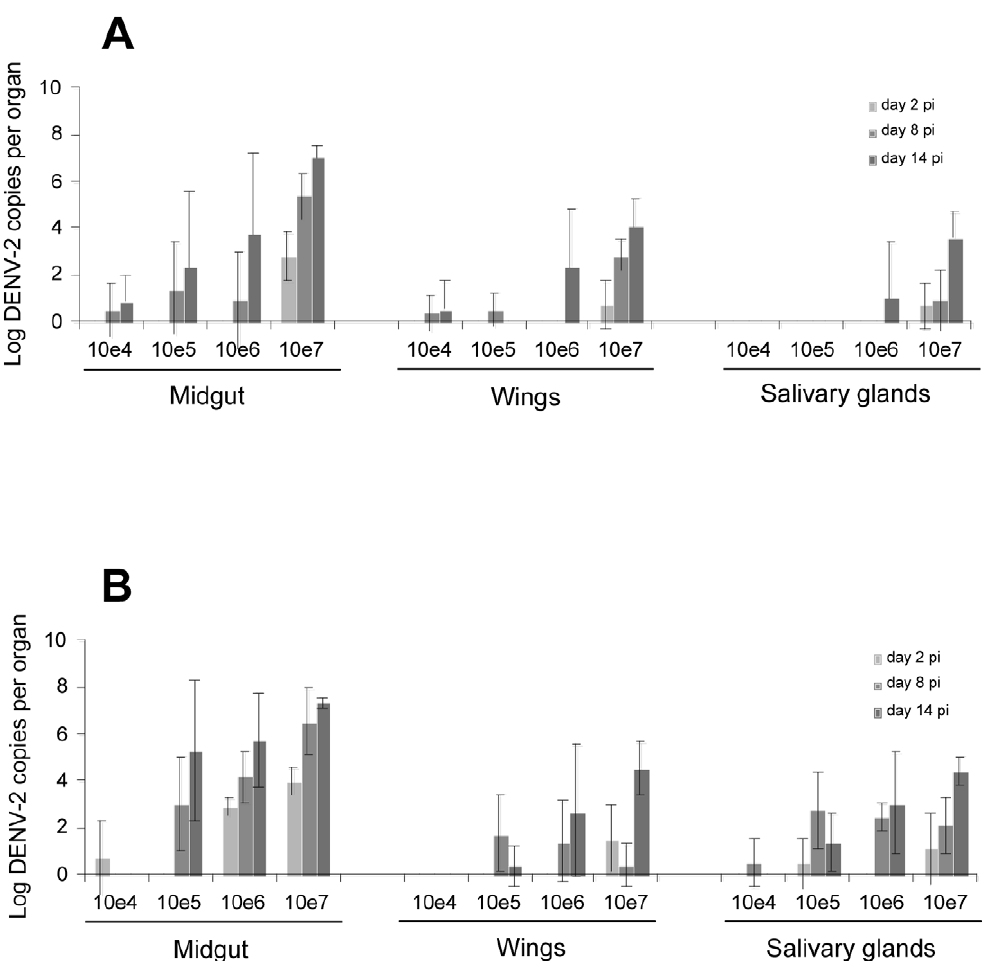
Figure 4. DENV-2 infection and dissemination in Wolbachia -infected and Wolbachia -uninfected Ae.albopictus . Wolbachia -infected (A) and Wolbachia -uninfected (B) mosquitoes were exposed to a DENV-2 blood-meal provided at 4 different titers, 10 4 , 10 5 , 10 6 , 10 7 FFU/mL. At days 2, 8 and 14 pi, midguts, wings and salivary glands were collected, and the number of DENV-2 genome copies was determined by qRT-PCR using primers targeting the C gene. Error bars indicate standard